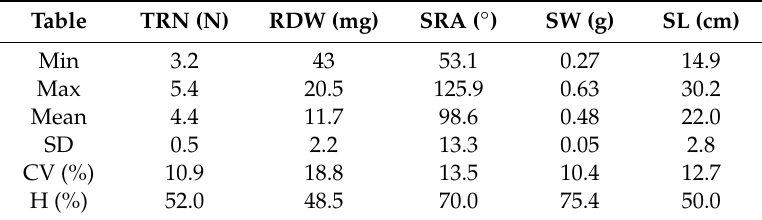
Table 1. Statistics of the seminal root traits.